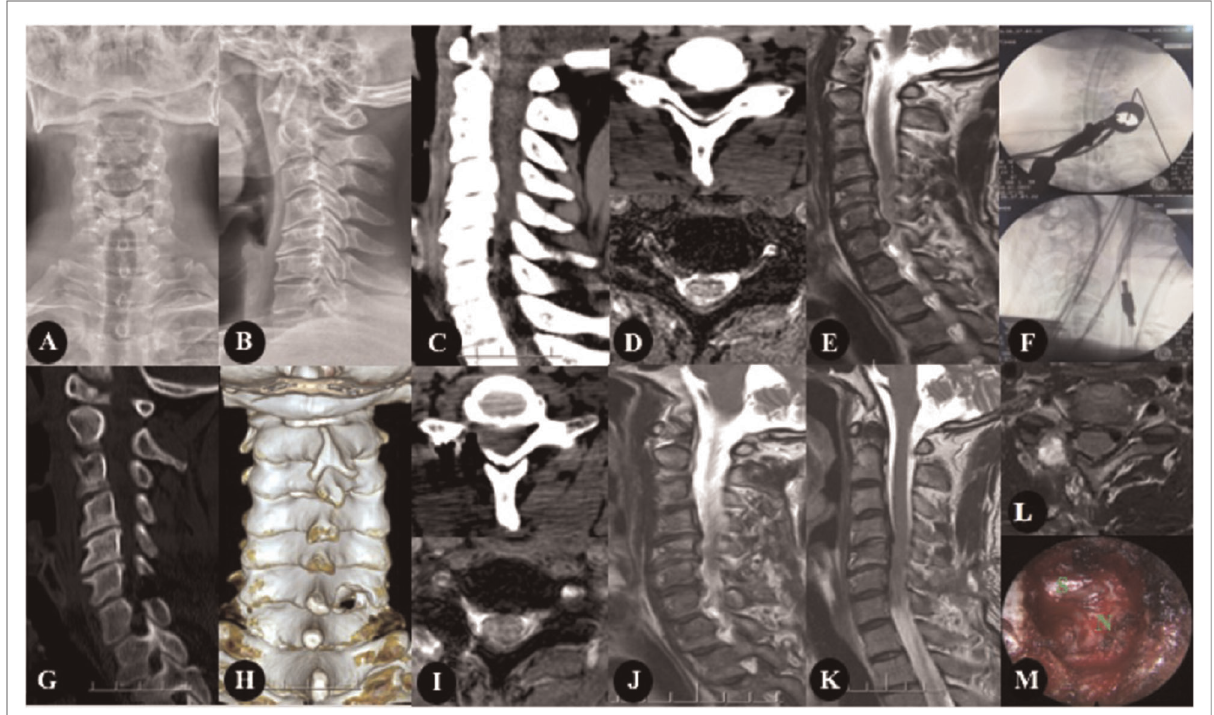
FIGURE 1 The patient, Male, 47 years old, was diagnosed with CSR(C6/7). ( A – E ) Preoperative imaging studies. ( A,B ) showed cervical kyphosis, without rotation, slippage and scoliosis. ( C,D ) showed there are osteophytes at the posterior edge of the vertebral body, and the intervertebral foramen area is not narrow. ( D,E ) showed cervical intervertebral disc protrusion, located in the right foramen region. ( F ) showed Intraoperative fl uoroscopy. ( G – L ) were the postoperative imaging examination, in which ( G – J ) were the re-examination data 3 days after the operation, and ( K,L ) were the re- examination data 1 year after the operation. ( G,I ) were CT images 3 days after operation, and The facet joints were well preserved and the range of fenestration was satisfactory. ( I,J ) showed that the nucleus pulposus in the right foramen area was completely removed. ( K,L ) showed there was no recurrence 1 year after operation. ( M ) showed intraoperative